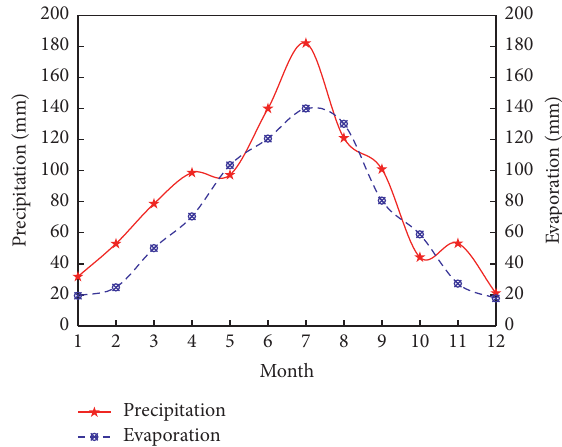
Figure 7: Annual distribution of precipitation and evaporation in Nanjing, East